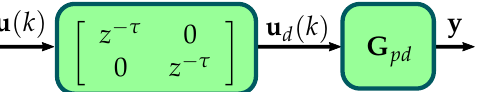
Figure 3. Input delay separation for the UPQC system model.